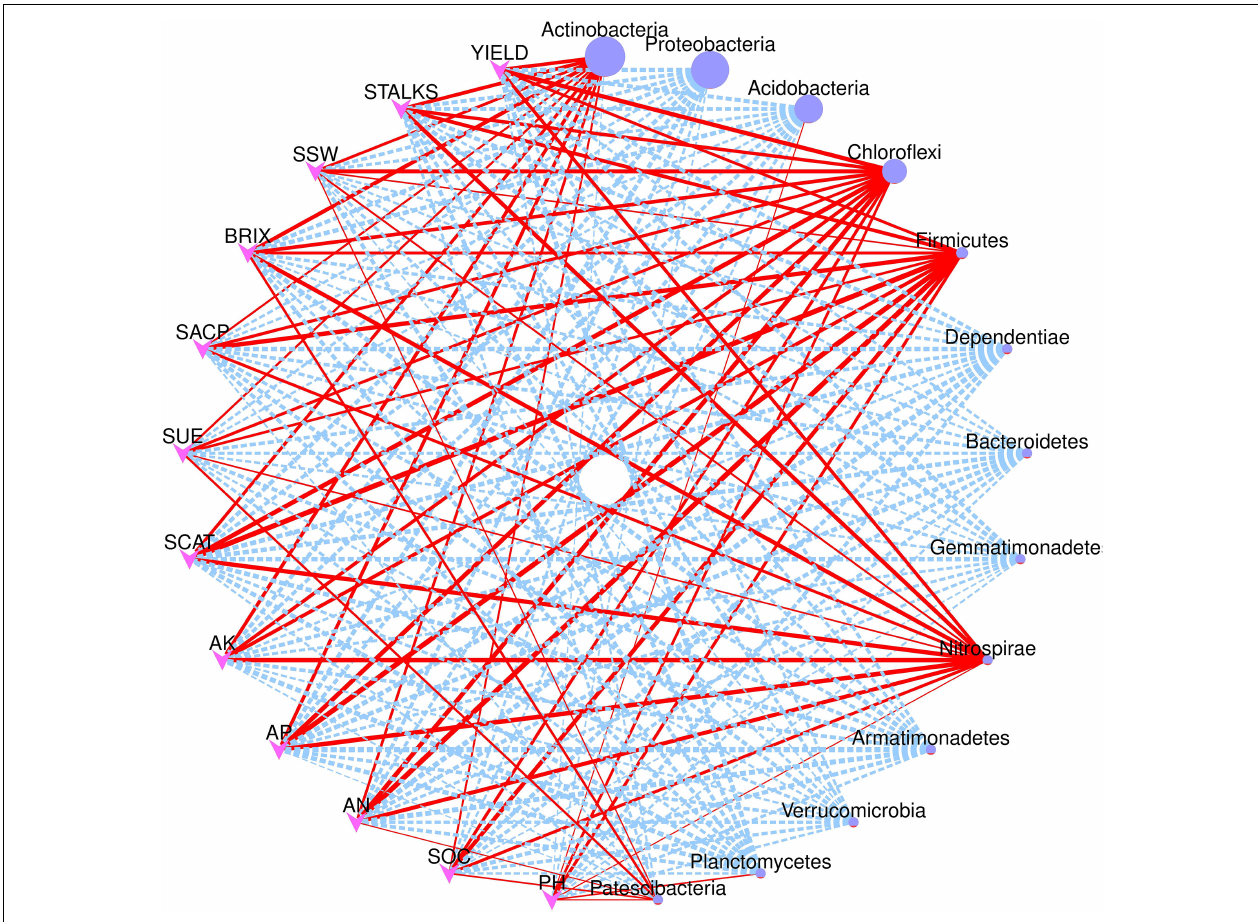
FIGURE 7 | Network correlation analysis of environmental factors and yield parameters with major bacterial phyla. Red solid line indicates positive correlation while dotted blue lines indicate negative correlation. The size of the nodes represents abundance level of each